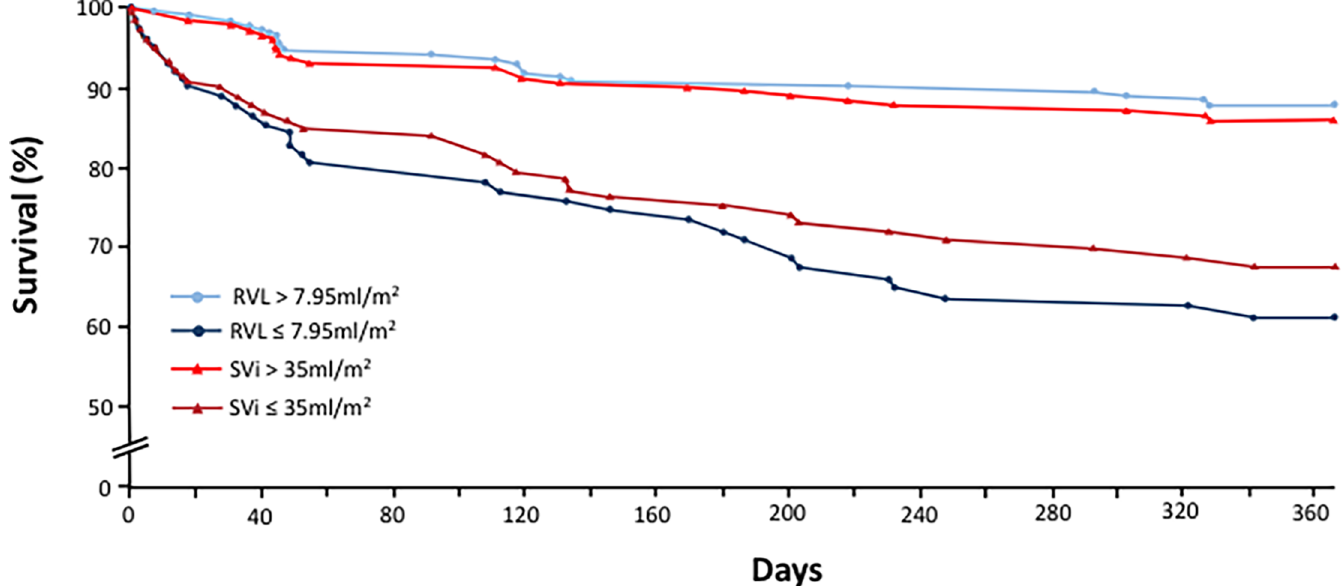
Fig 2. Kaplan-Meier survival curves post-TAVR based on RVL and SVI. RVL = Relative Valve Load, SVI = stroke volume index. https://doi.org/10.1371/journal.pone.0195641.g002 10.96% in patients with RVL > 7.95ml/m 2 (Chi square value 9.39, LR 7.36, p = 0.0068). In